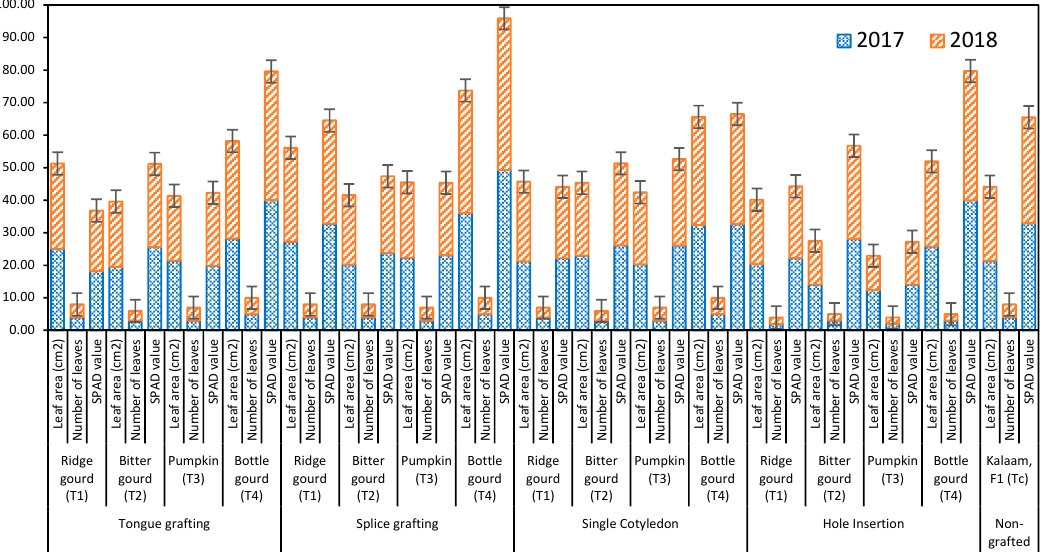
Figure 1. Evaluating the effect of Scion/rootstocks combinations (grafting) on vegetative growth of Cucumber fruit after 15 days during crop season 2017 and 2018.